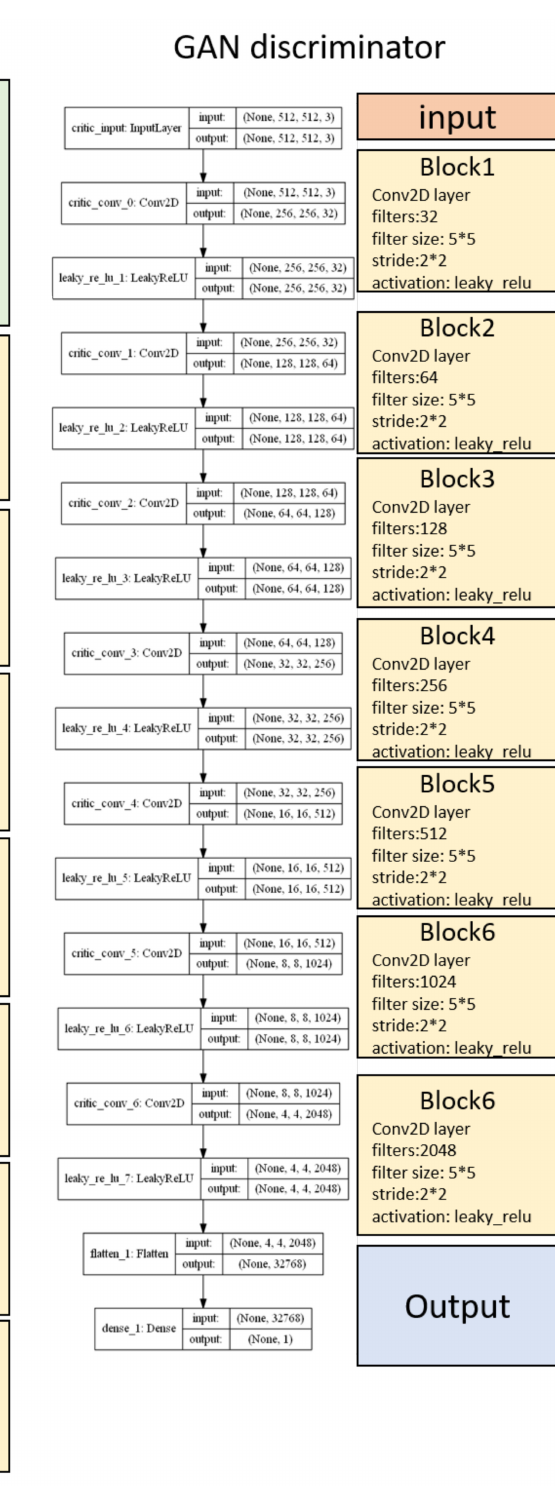
Figure 4. Generator and discriminator structure of our modified